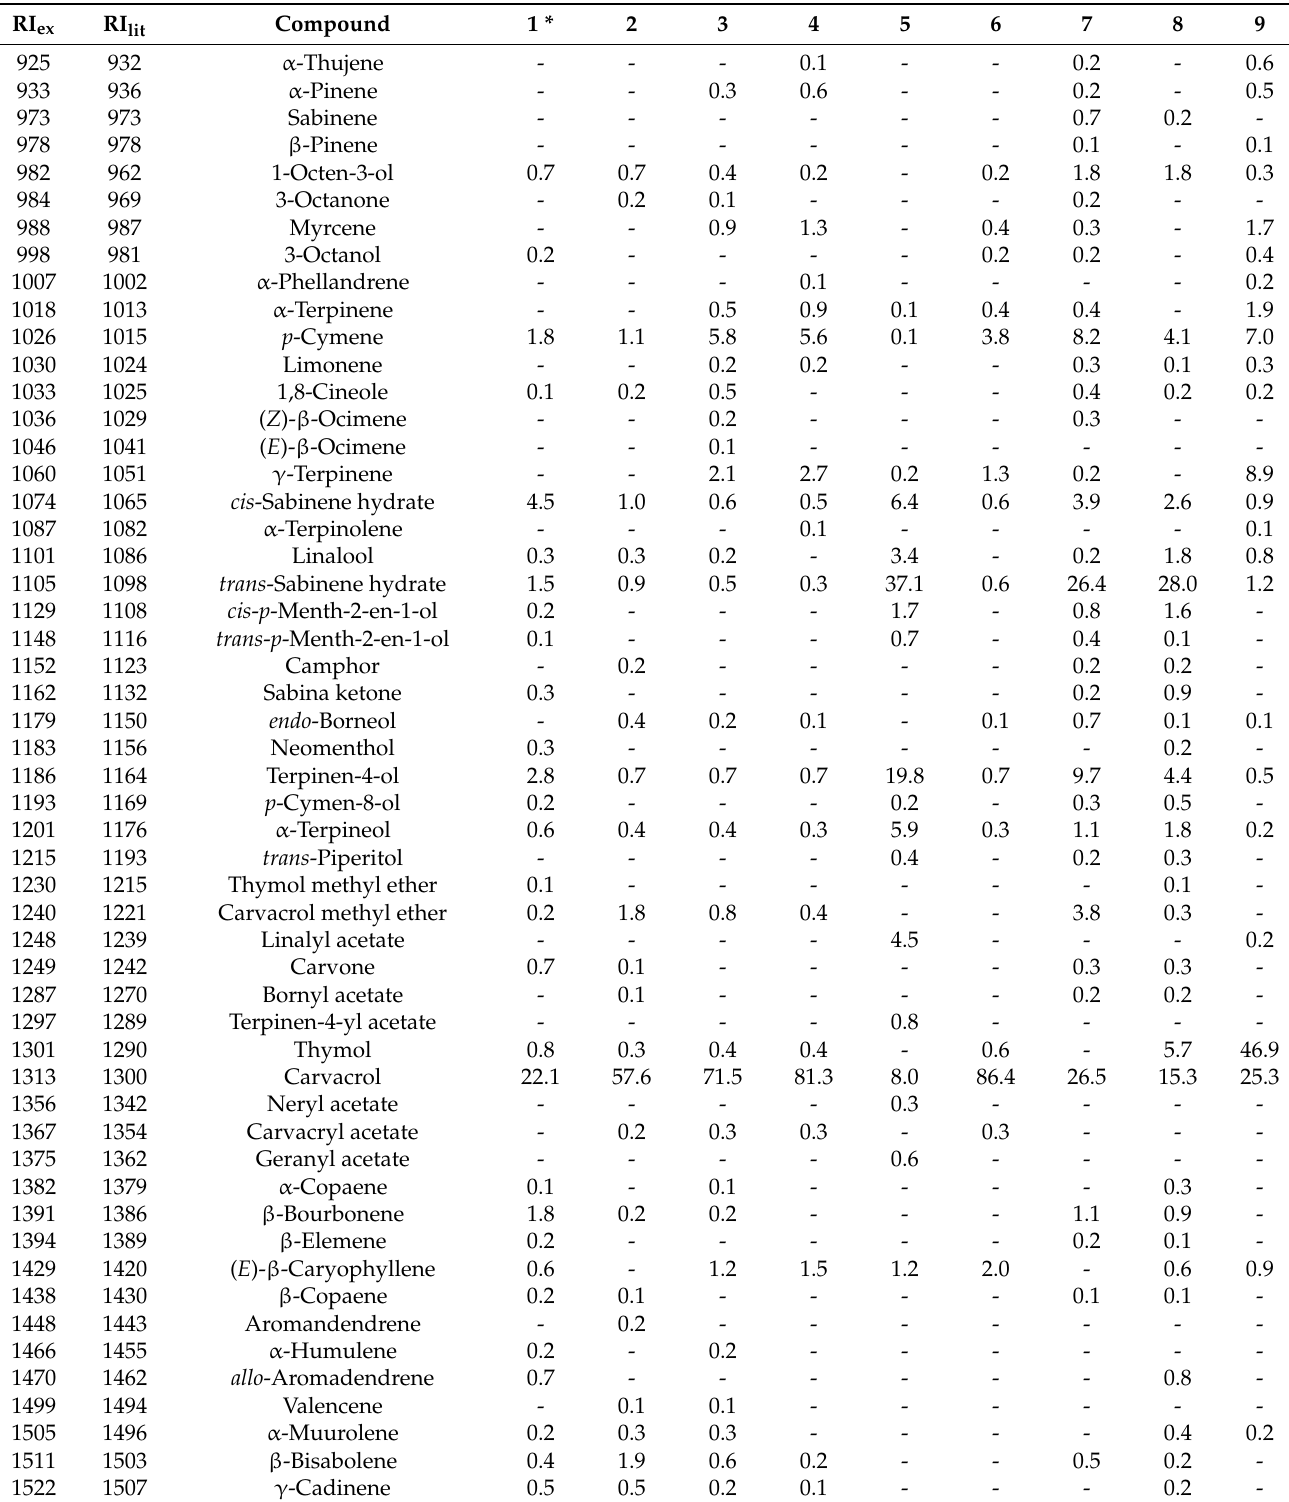
Table 1. The chemical composition—relative amounts [%] of examined oregano essential oils; RI ex —Retention index on ZB-5MS column, RI lit —Retention index from the literature